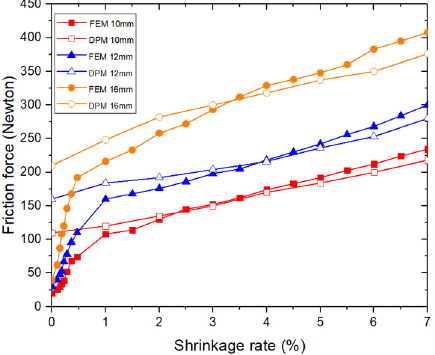
Figure 3. Finite element model of the two-section pipeline robot.